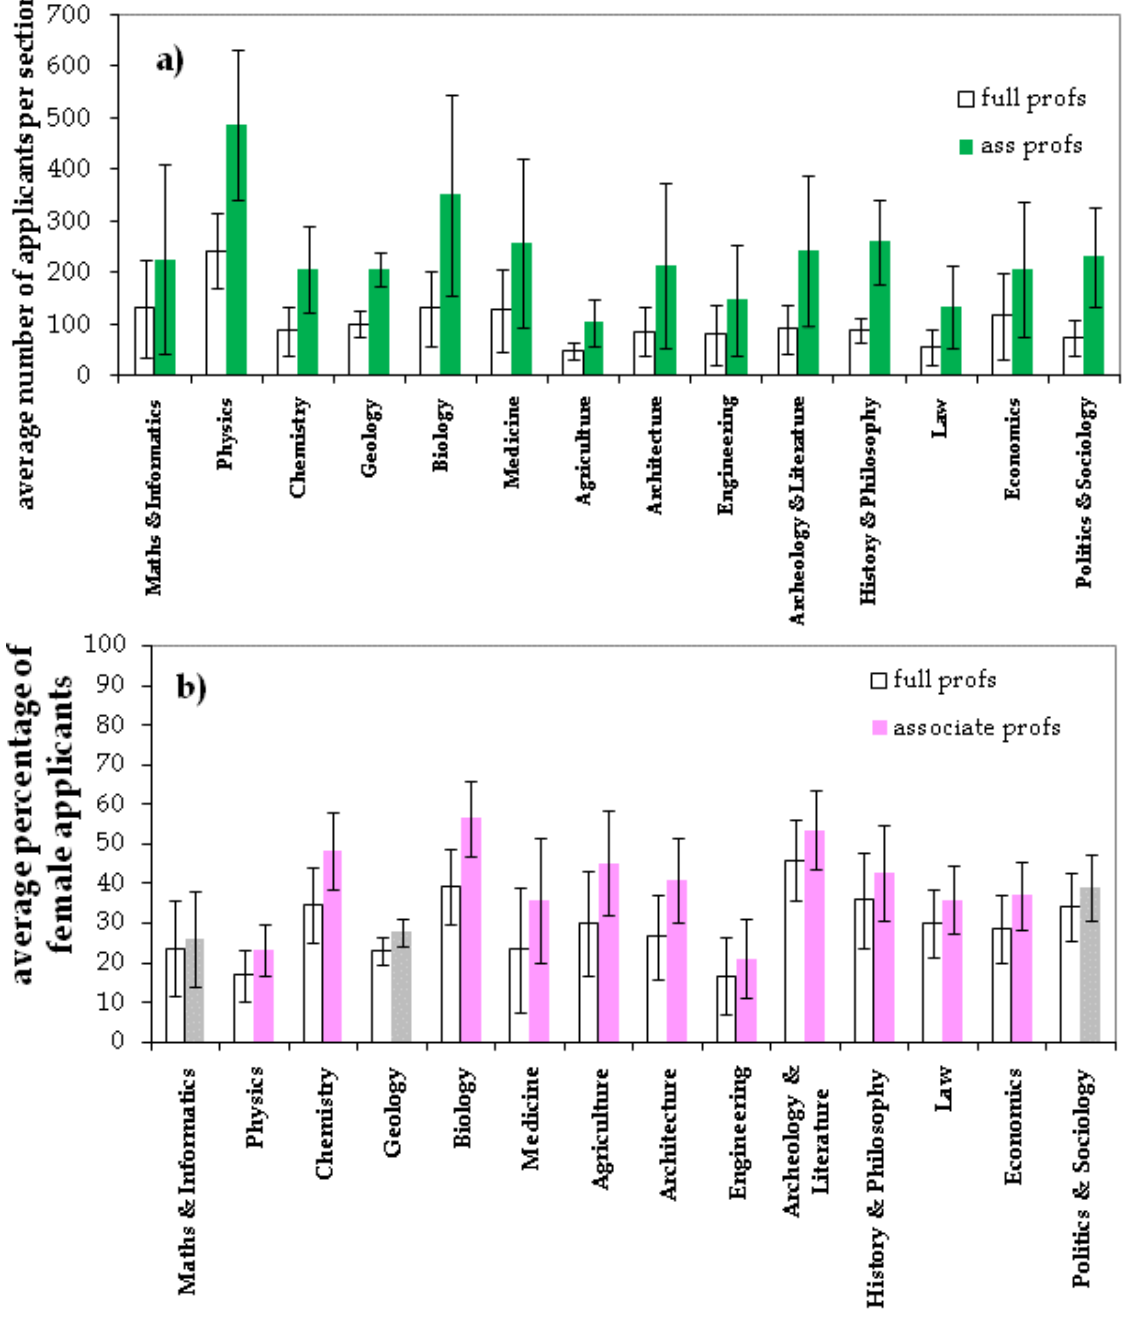
Figure 1. Frequency distribution in the 14 fields of the Italian national habilitation competition (2012) of ( a ) the average number of applications per sub-field, and ( b ) the average proportion of female applications (associate and full professor levels). Significant differences (paired t -test, all with p < 0.01) are shown in colour. The only non-significant differences are in the panel (b) for mathematics and informatics ( p = 0.18), geology ( p = 0.28), and politics and sociology ( p = 0.25). Error bars show standard